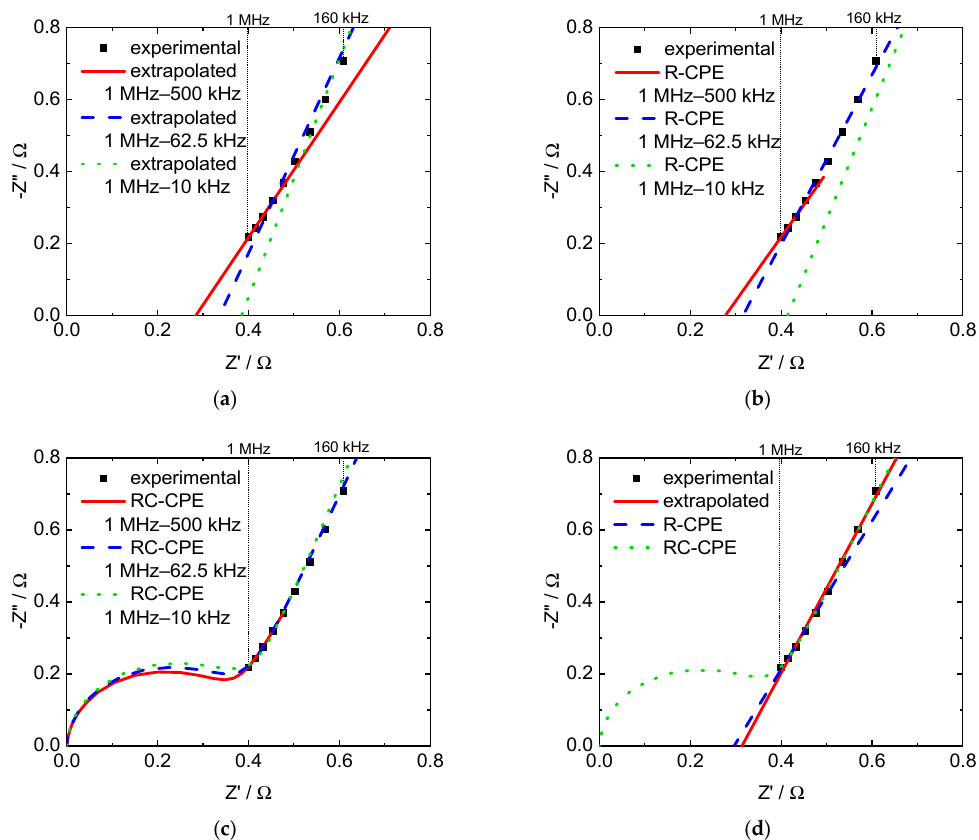
Figure 6. Nyquist plots with extrapolated and modeled through-plane impedance data for a 3M 825 EW membrane, ( a ) linear extrapolation, ( b ) R-CPE model, ( c ) RC-CPE model and ( d ) comparison of all three evaluation methods in the frequency range from 1 MHz to 160